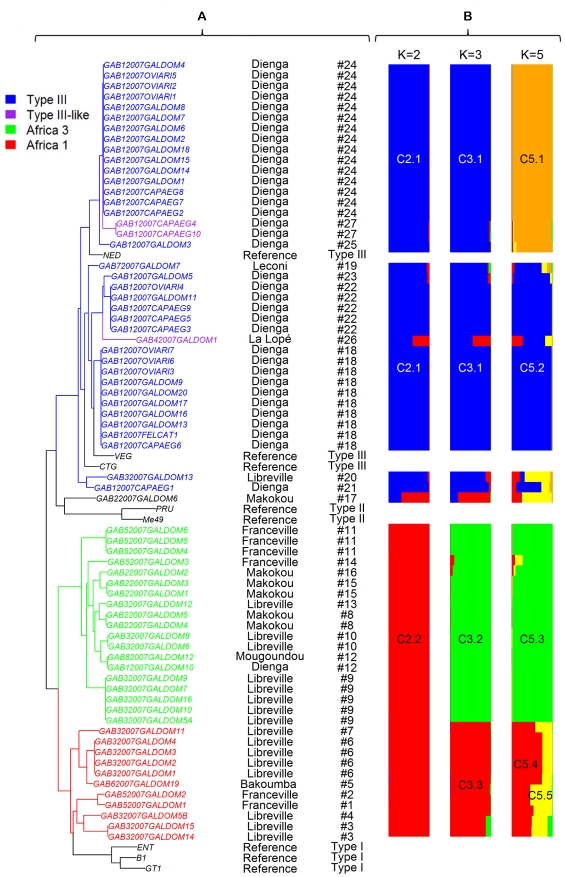
Neighbor-joining tree and clusters as inferred from Cavalli-Sforza distances and by STRUCTURE calculated for 13 microsatellite markers and on all 69 Gabonese T. gondii strains.A: Neighbor-joining tree as inferred from Cavalli-Sforza distances on all 69 Gabonese T. gondii strains and seven Type reference strains. Midpoint rooting was applied for the Neighbor-joining tree; no outgroup was used. Geographical origin and genotype membership (# genotype number) for each strain are reported. Colors correspond to colors of populations found with STRUCTURE for K = 3 (blue, green and red for respectively cluster C3.1, C3.2 and C3.3 and black for the single isolate strain: GAB4-2007-GAL-DOM1 and for Type reference strains), except for Type III-like isolates which are in purple. B: Clusters as inferred by STRUCTURE on all 69 Gabonese T. gondii strains. K = 2, K = 3 and K = 5 are indicated by bars in different colors next to the tree. The partition (i.e. relative qik) of each of the 69 T. gondii strain genotypes within each cluster for the most likely number of inferred clusters K = 2, 3 and 5 is presented.